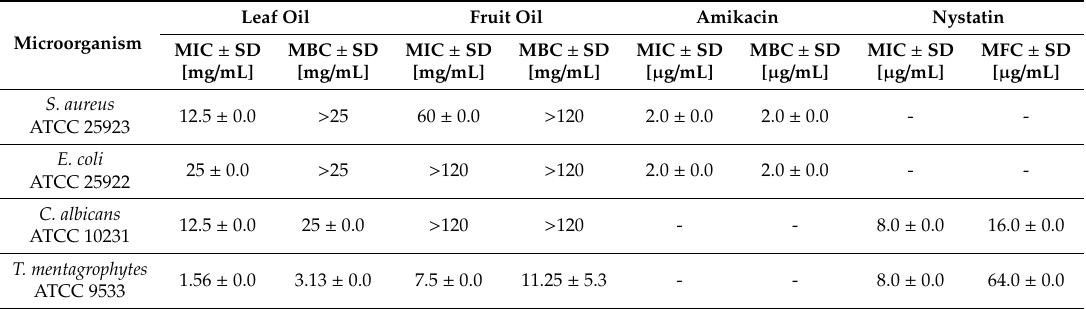
Table 3. The activity of the essential oils from E. maritimum leaves and fruits against standard microbial